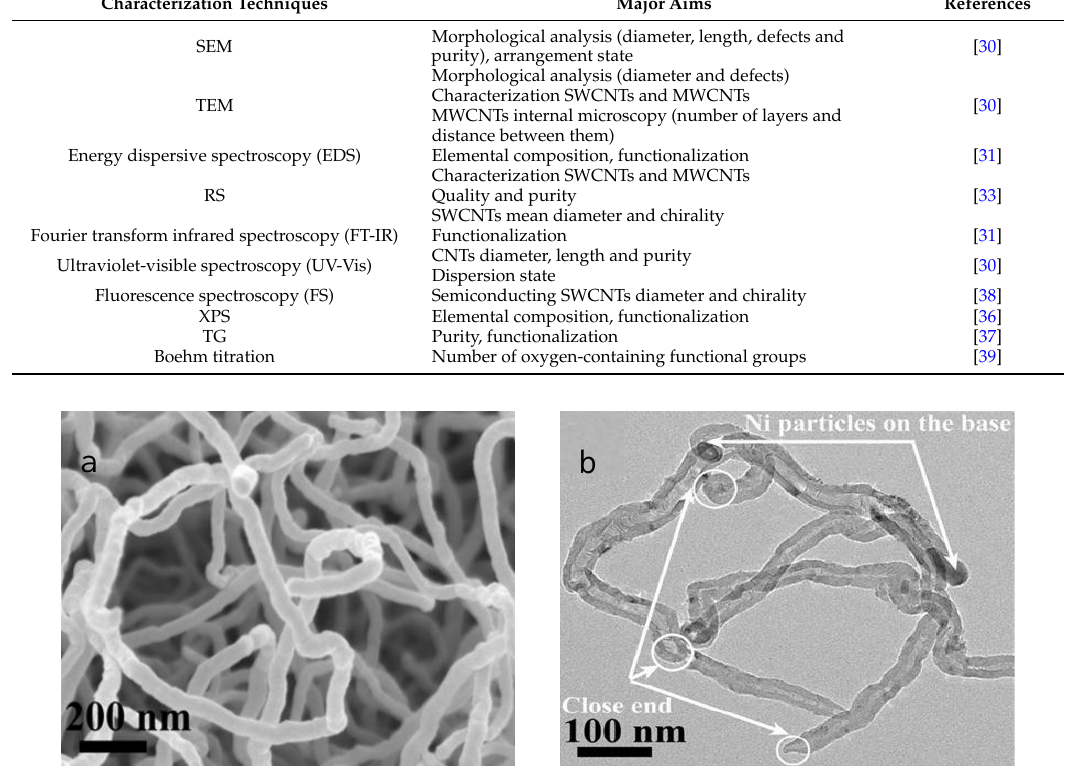
Table 1. Characterization techniques of CNTs.